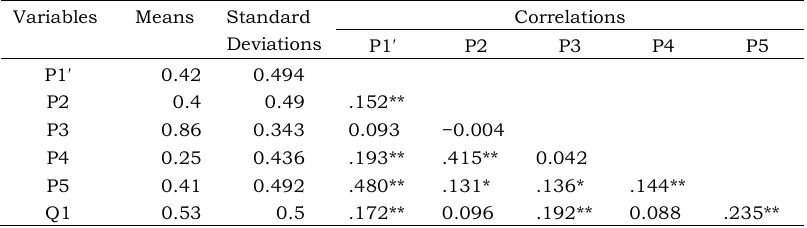
Table 1. Means, standard deviations, and correlations of questionnaire B Variables